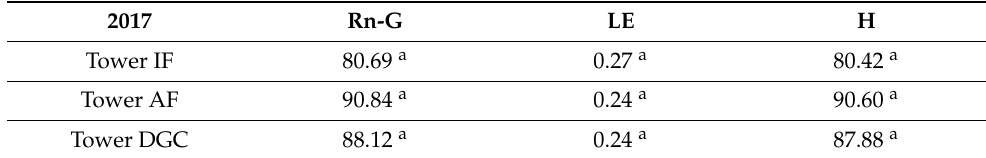
Table 2. Energy balance (W/m 2 , hourly average) for Rn-G, LE and H by closure for Towers IF, AF and DGC for the year 2017. Where Rn is net radiation, G is soil heat flux, LE is latent heat of evaporation and H is sensible heat. Significance based on Kruskal-Wallis one-way ANOVA on ranks ( p < 0.05). Values with different letters indicate significant differences at p < 0.05.